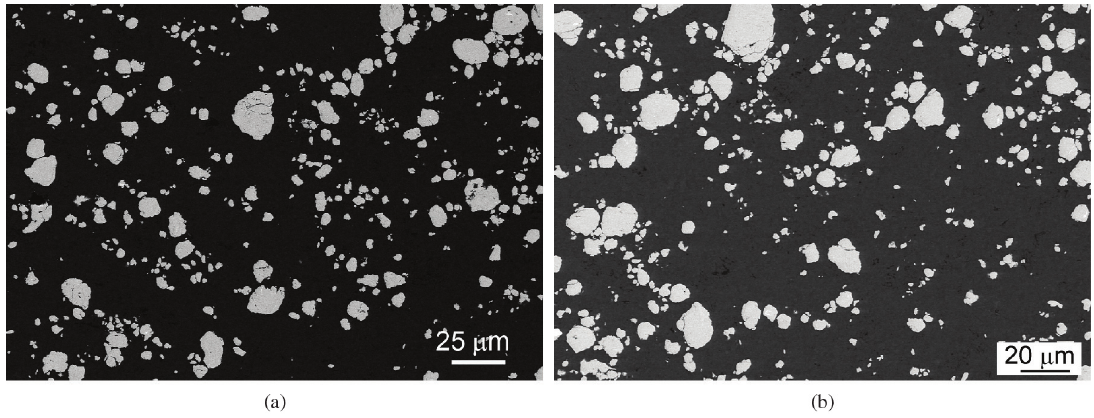
Figure 2. SEM images obtained by back-scattered electrons showing FeAlCr particles distribution in composite after ECAP. (a) 3 ECAP passes at RT by route A; (b) 4 ECAP passes at 150°C by route B